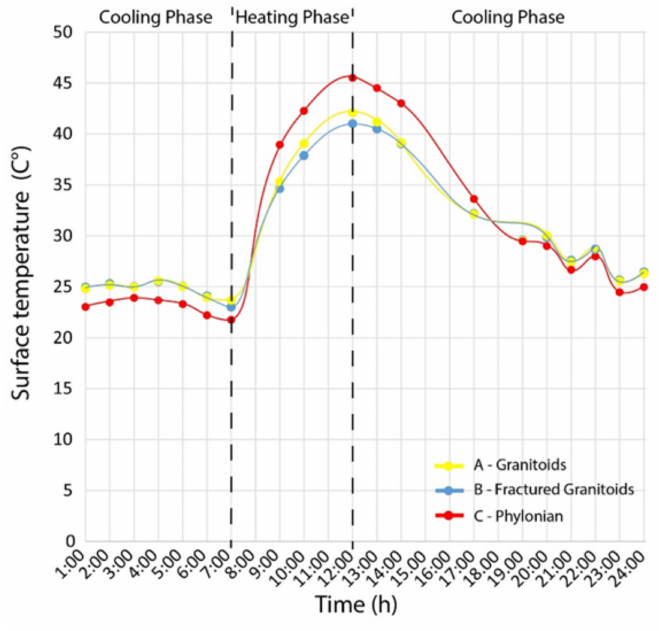
Figure 4. Cooling and heating phases computed from thermograms over 24 h.